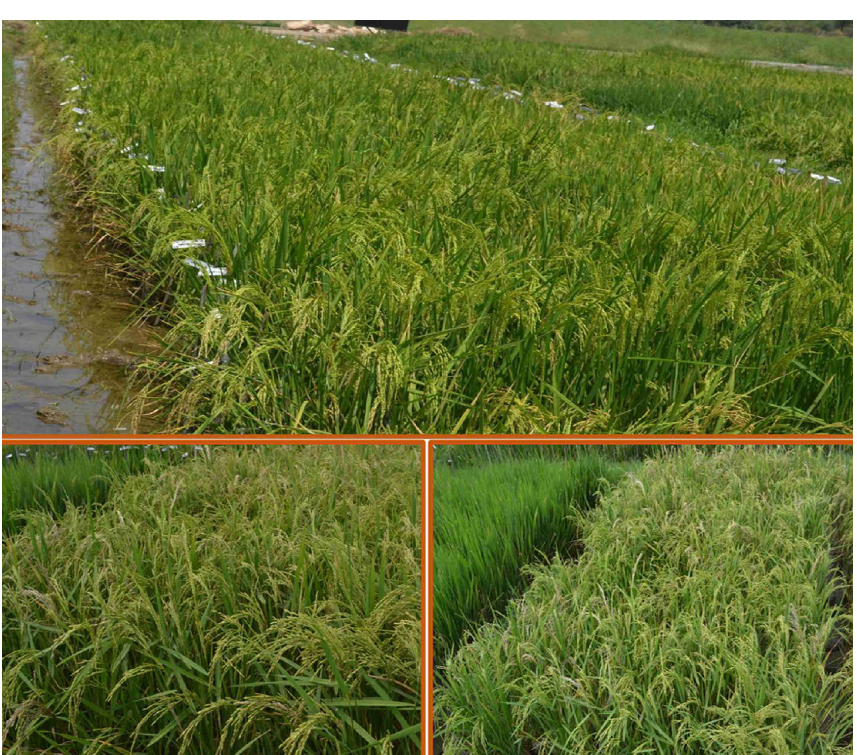
Figure 6. Overview of field at anthesis stage (E1C) during 2013–14 (Top); Hybrid (IR79156A × EPLT104) (E2C) during 2014–15 (Bottom left); Hybrid (IR58025A × 50-10) (E2C) during 2014–15 (Bottom